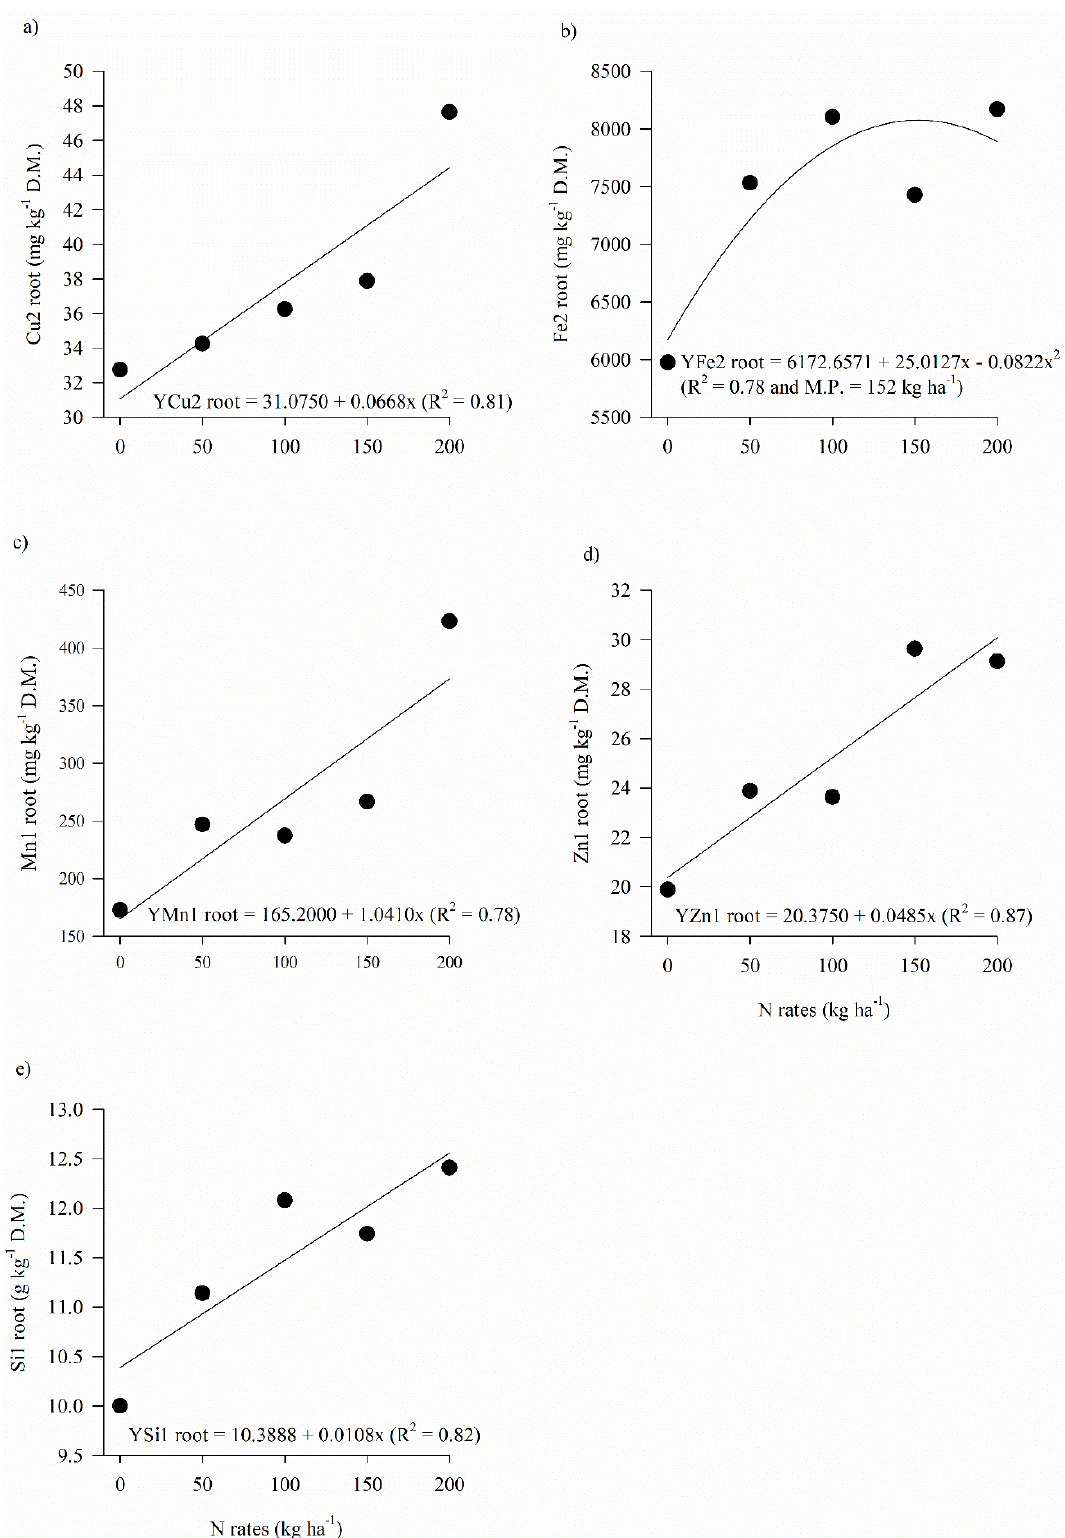
Figure 4. Effect of N rates in Cu (a), Fe (b), Mn (c) Zn (d) and Si (e) concentration in root. Selvíria, MS – Brazil, agricultural crop 2015/2016 1 and 2016/2017